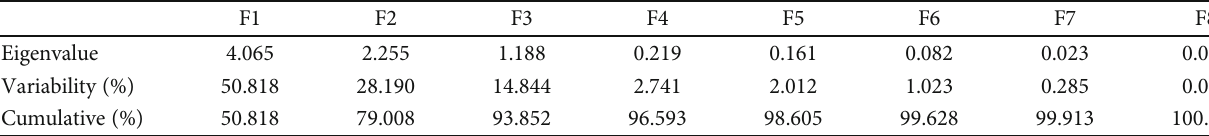
Figure 4: Comparison of the X-ray di ff ractograms obtained before and after aging for (a) paper sample 1.0.2 (egg white-alum sizing and Hlevan adhesive) and (b) paper sample 1.0.3 (egg white-alum sizing and starch adhesive). Table 3: Eigenvalues of factors in PCA.